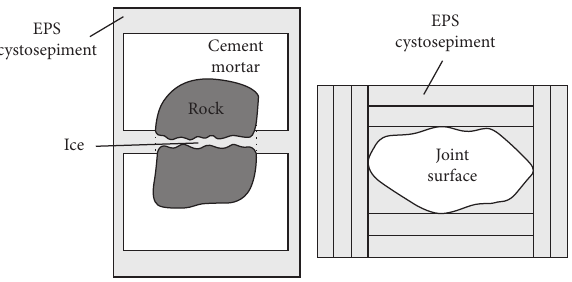
Figure 3: Schematic of